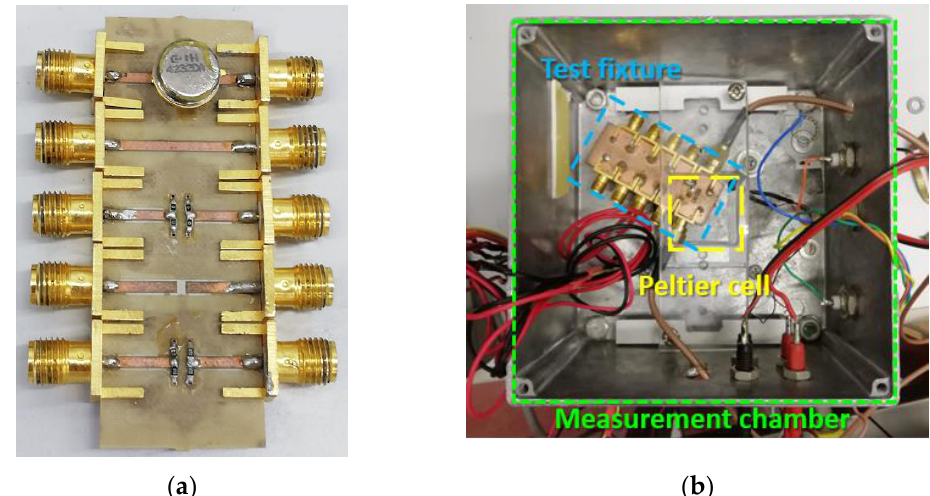
Figure 2. ( a ) DUT connected to the test fixture. ( b ) Measurement chamber with the test fixture mounted on the Peltier cell.